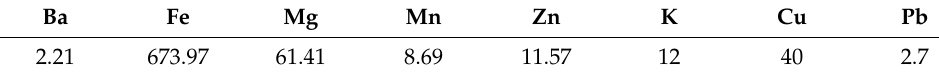
Table 2. Extractable minerals present in SDB (mg kg − 1